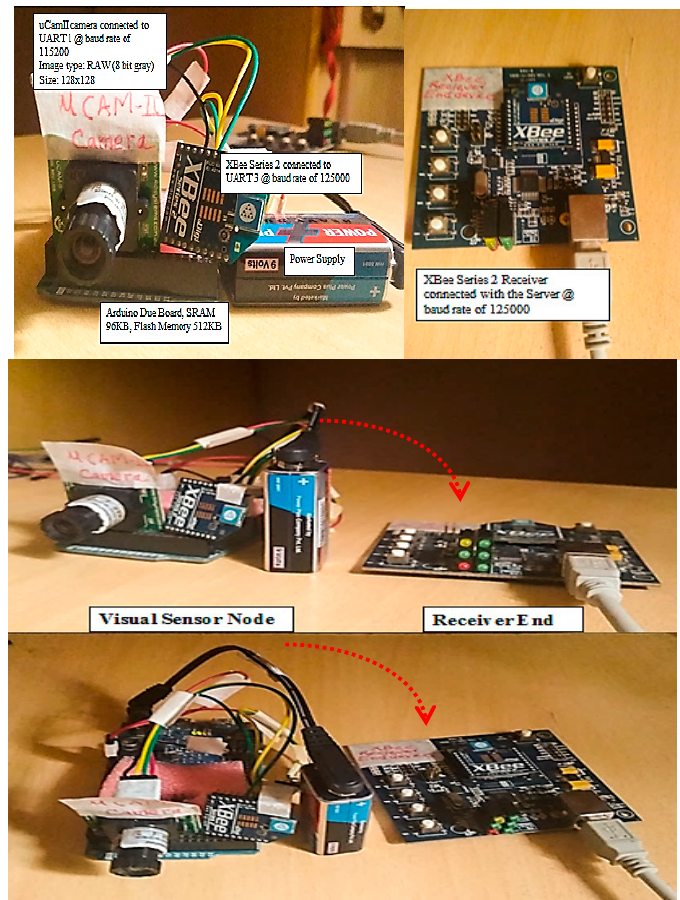
Figure 11 . Different views of the constructed visual node and its transmission setup . Figure 11. Di ff erent views of the constructed visual node and its transmission